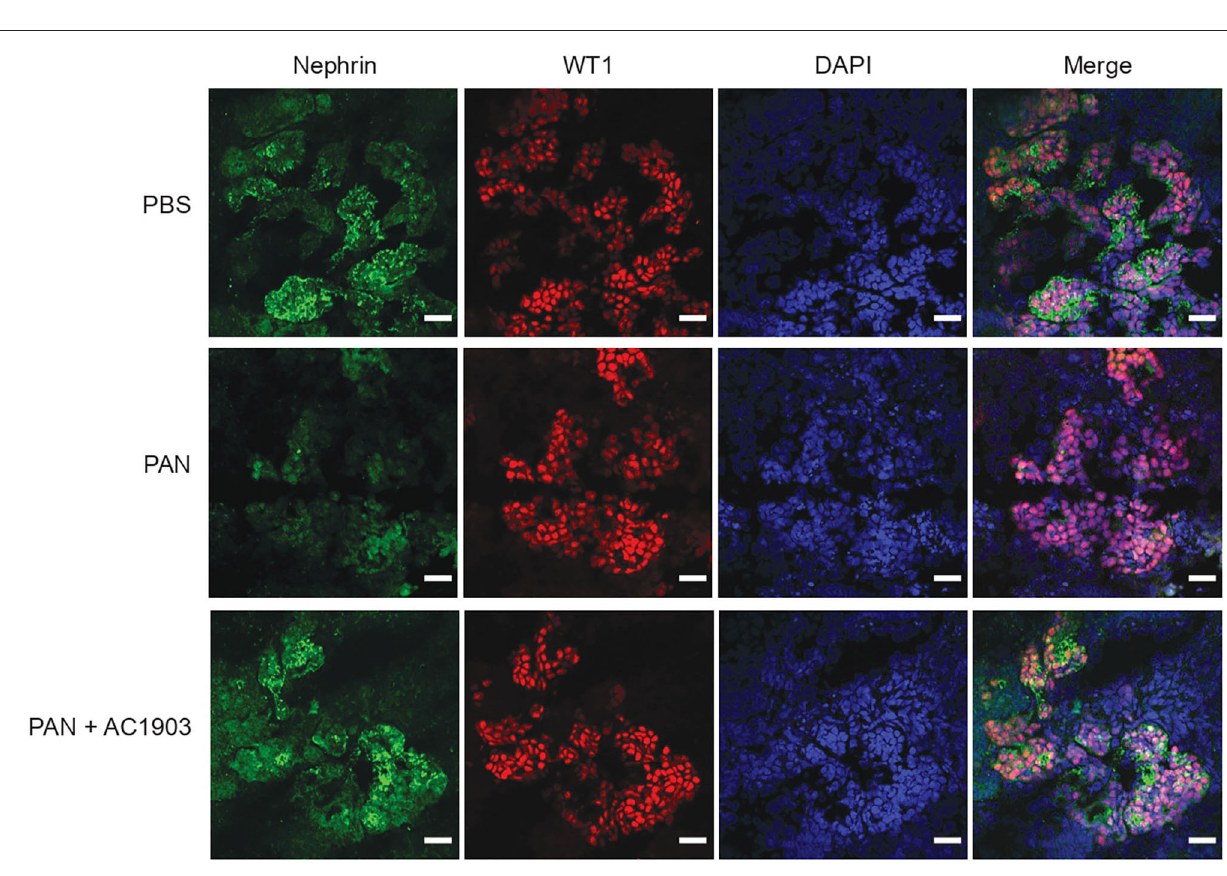
FIGURE 4 | Inhibition of TRPC5 protects podocytes from injury in human kidney organoids. Representative immunostaining images of podocyte cytoskeletal and marker proteins, nephrin (Green) and WT1 (Red) in PBS, PAN and PAN + AC1903 treated human kidney organoids. Scale bar 20 µ